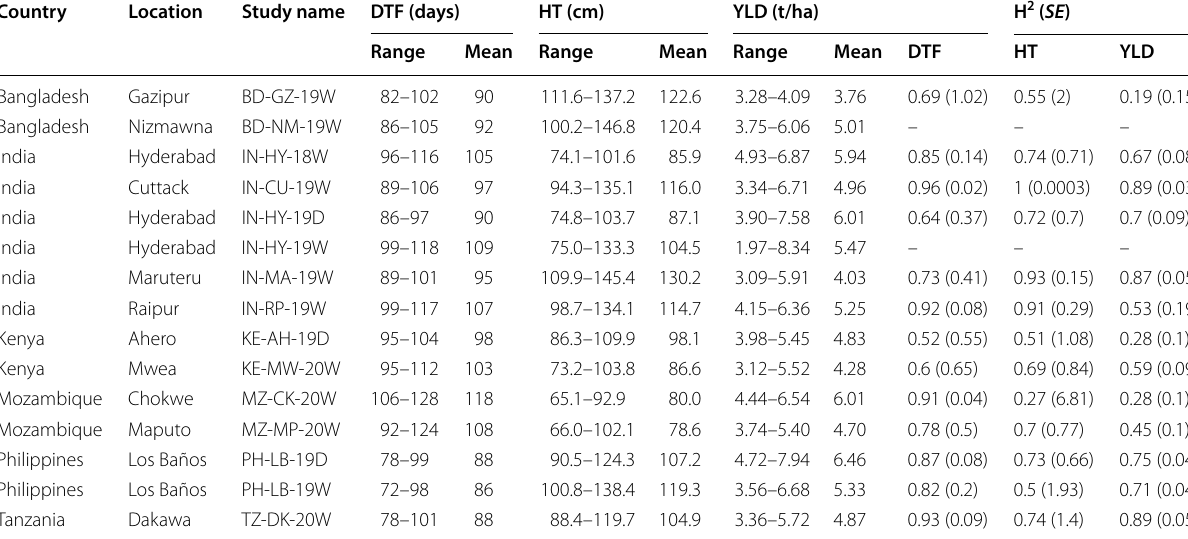
DTF days to flowering; HT plant height; YLD grain yield. In the two environments of Bangladesh-Nizmawna and India-Hyderabad, the broad-sense heritability was not calculated due to the experimental design without replications